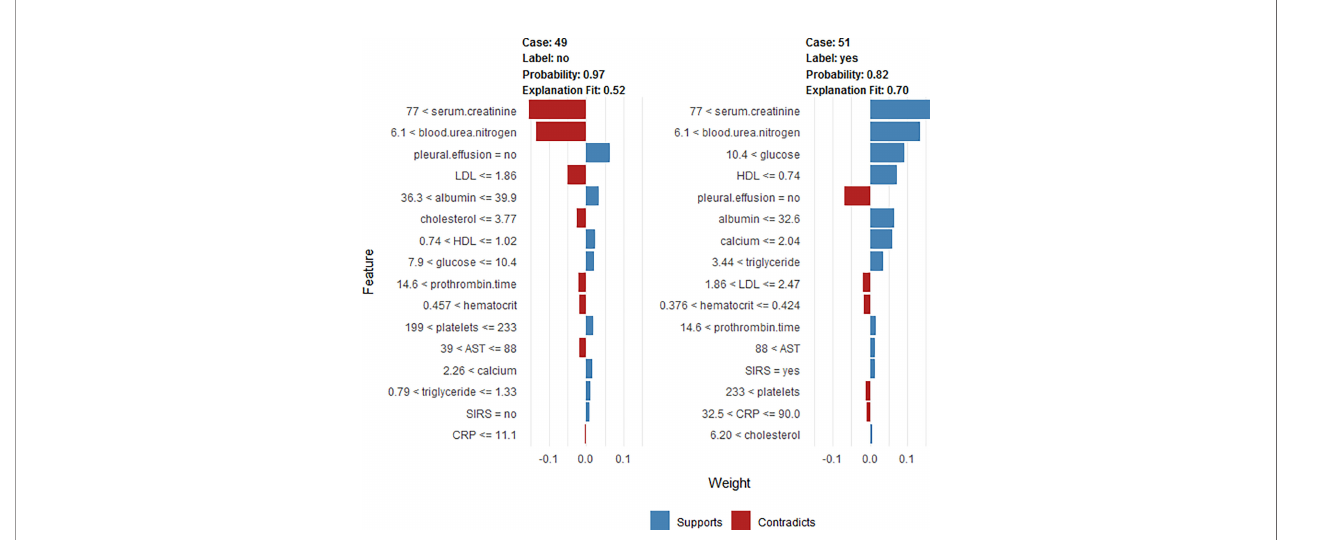
FIGURE 8 | LIME plot for the individualized likelihood of two typical predictions. This shows the main contributing features behind the model prediction. The length of the color bar represents the amount of contribution. The fi rst case (case 49) is a non-SAP patient who was correctly classi fi ed, with a prediction probability of 0.97 as non-SAP based on the RF model. The fi rst case (case 49) had a creatinine value of 86 m mol/L, BUN=7.1 mmol/L, no pleural effusion, LDL=1.82 mmol/L, albumin=36.5 mg/dl, total cholesterol=3.24 mmol/L, HDL=0.79 mmol/L, glucose=8.4 mmol/L, prothrombin time=15.2 s, hematocrit=0.465, platelets=206×10^9/L, AST=76 U/L, calcium=2.43 mmol/L, triglyceride=0.96 mmol/L, no SIRS, and CRP=5 mg/L. The second case (case 51) is an SAP patient who was correctly classi fi ed, with a prediction probability of 0.82 (SAP based on RF model). The second case (case 51) had a creatinine value of 260 m mol/L, BUN=16.6